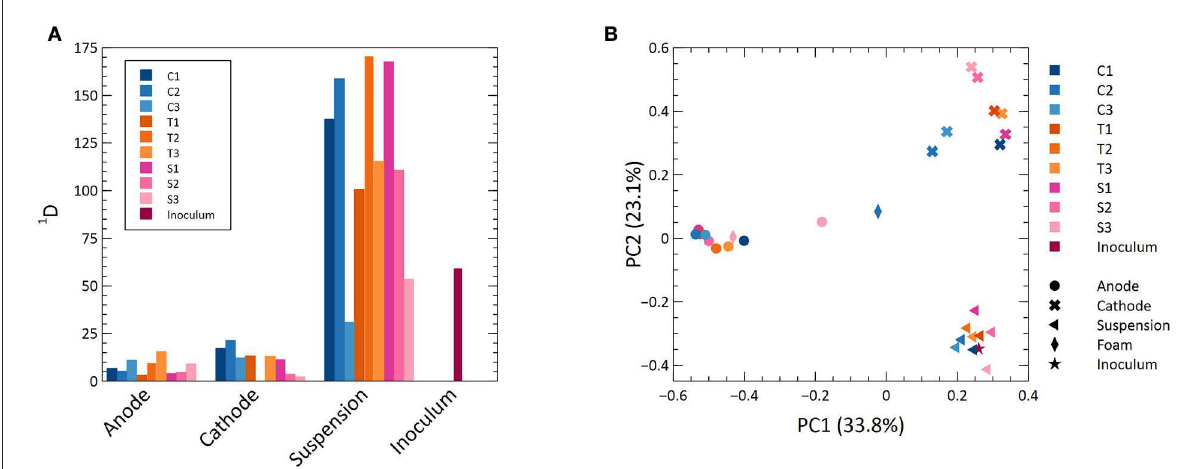
FIGURE4 (A) A bar graph with the alpha diversity values for all samples at a diversity order of 1. (B) Principal coordinate analysis of dissimilarities at a diversity order of